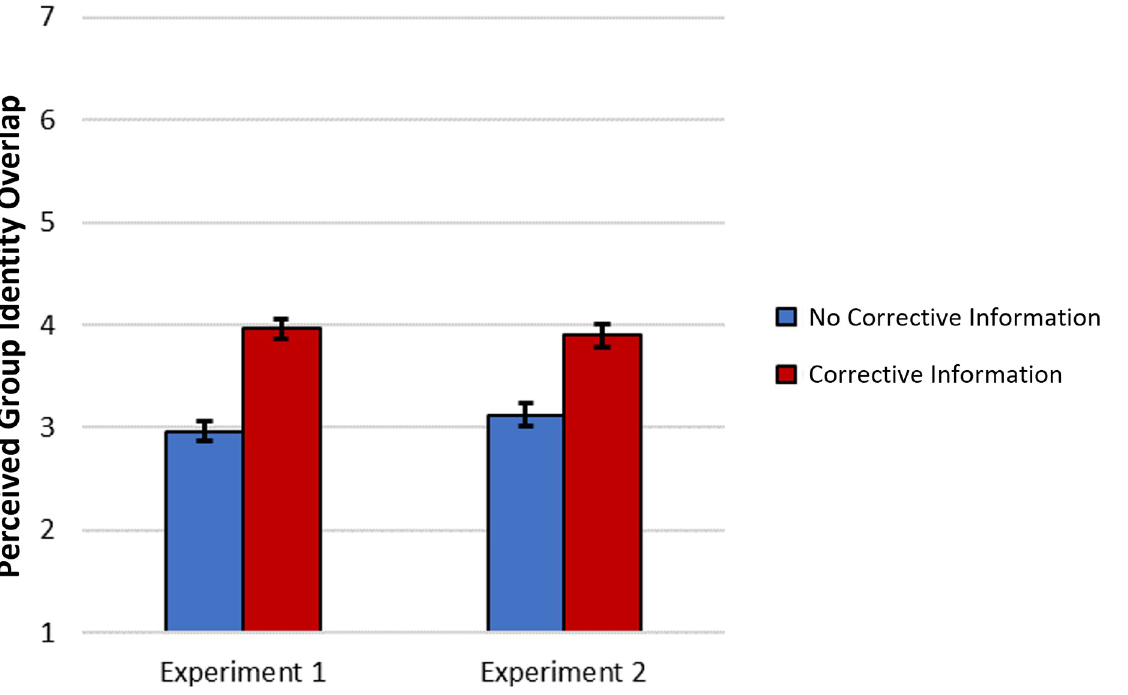
Fig 1. Perceived group identity overlap between gun owners and non-gun owners as a function of corrective information condition data from Experiments 1 ( N = 195 gun owners) and 2 ( N = 696 gun owners). Error bars represent 95% confidence intervals.